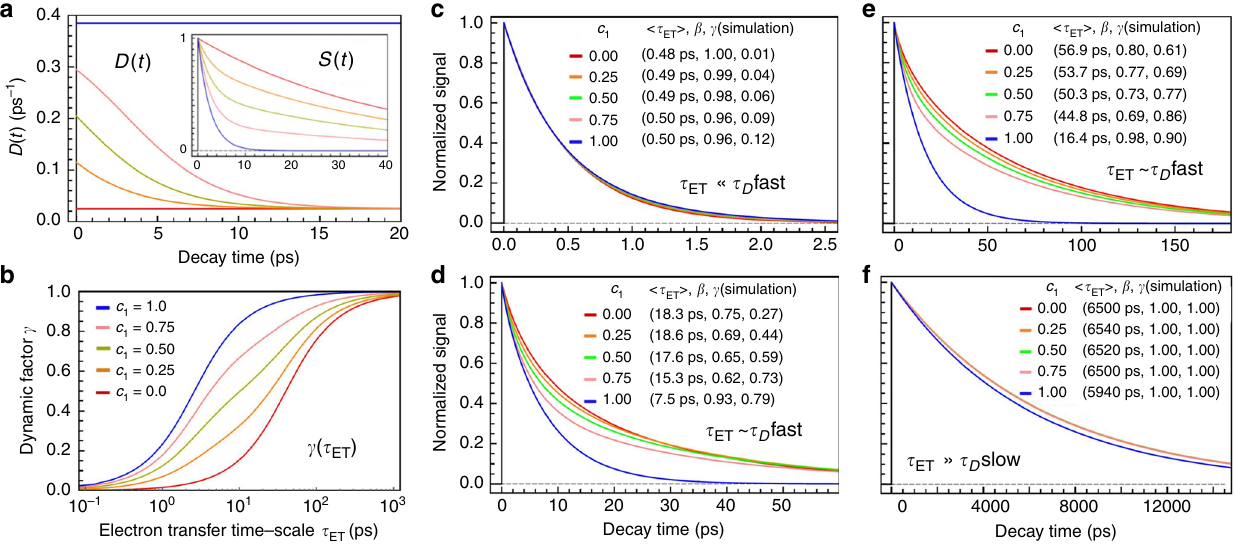
Fig. 4 Simulations of ET dynamics with bi-exponential solvation process. The solvation correlation function is given by, S t ð Þ ¼ c 1 e (cid:2) t = τ fast D þ 1 (cid:2) c 1 ð where τ fast D ¼ 2 : 6 ps, and τ slow D ¼ 40 ps. a Evolution of the diffusion coef fi cient, D ( t ) (Eq. 25), with different values of c 1 . The inset is the evolution of S ( t ) (Eq. 14). b Evolution of the dynamic factor γ as a function of τ ET with different values of c 1 . c Simulations of ET dynamics with different values of c 1 while τ values of parameters used are, J = 0.02eV, Δ G o = − 0.9eV, λ i = 0.8eV, λ eq o ¼ 0 : 4 eV, and Δ E sol = 0.026eV. d Simulations of ET dynamics with different (cid:6) τ fast Δ G o = − 0.6eV, and other parameters are the same as c . e Simulations of ET dynamics with different values of c values of c 1 while τ D . Here, ET τ (cid:6) τ slow Δ G o = − 0.5eV. f Simulations of ET dynamics with different values of c D . Here, ET